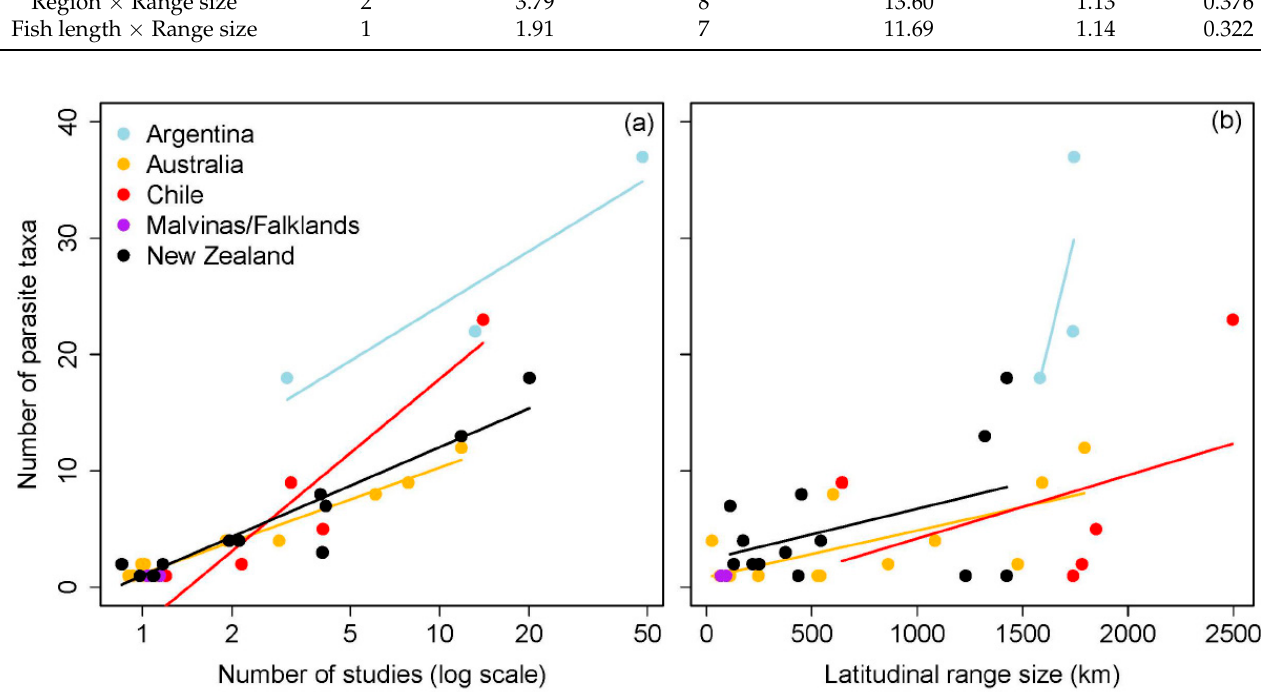
Figure 1. Influence of the ( a ) number of studies (log scale) and ( b ) latitudinal range size (km) on the number of parasite taxa reported for each galaxiid species per geographic region.